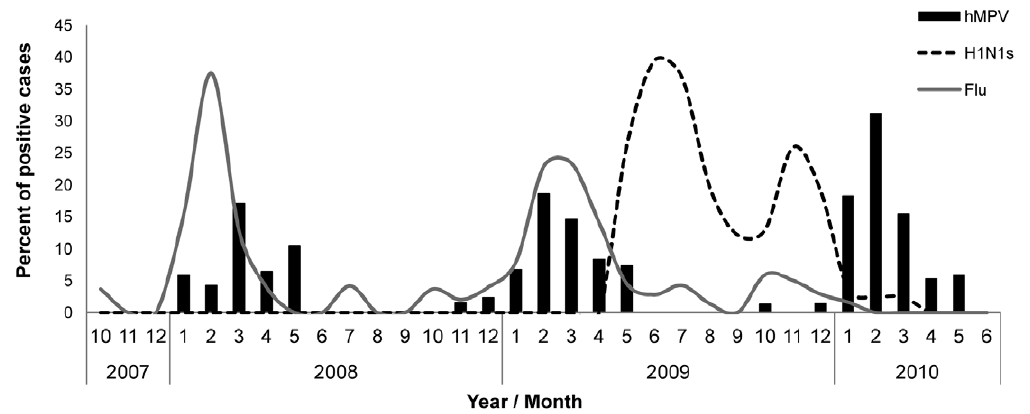
Figure 6. Respiratory viruses circulating in the country during the study period. The figure depicts percentages of patients hospitalized due to influenza-like symptoms that were found positive for infection with either influenza (A and B), with pandemic influenza (H1N1s) and hMPV between 2007–2010.